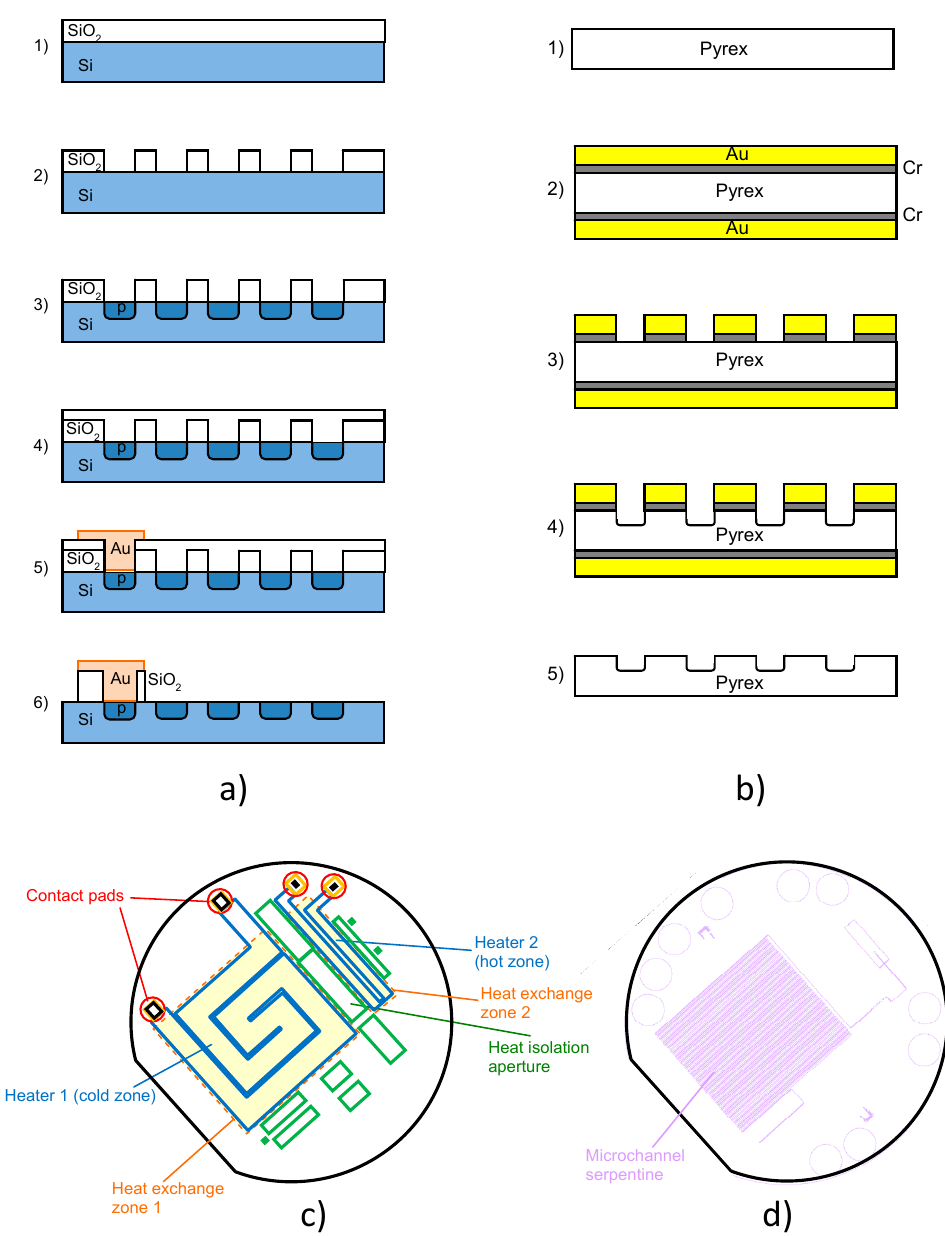
Figure 2. ( a ) Steps for fabrication of p-type Si heater; ( b ) steps for fabrication of microchannel in Pyrex glass; ( c ) photolithographic masks for fabrication of integrated p-type heater in silicon (overlapped, color-coded: blue denotes heaters, green are heat barrier apertures, red are contact pads.) The pale yellow fields bounded by dashed orange lines are the heat exchange zones (coinciding with the serpentine microchannel area in Pyrex); ( d ) photolithographic mask defining the meandering microchannel route in Pyrex glass.